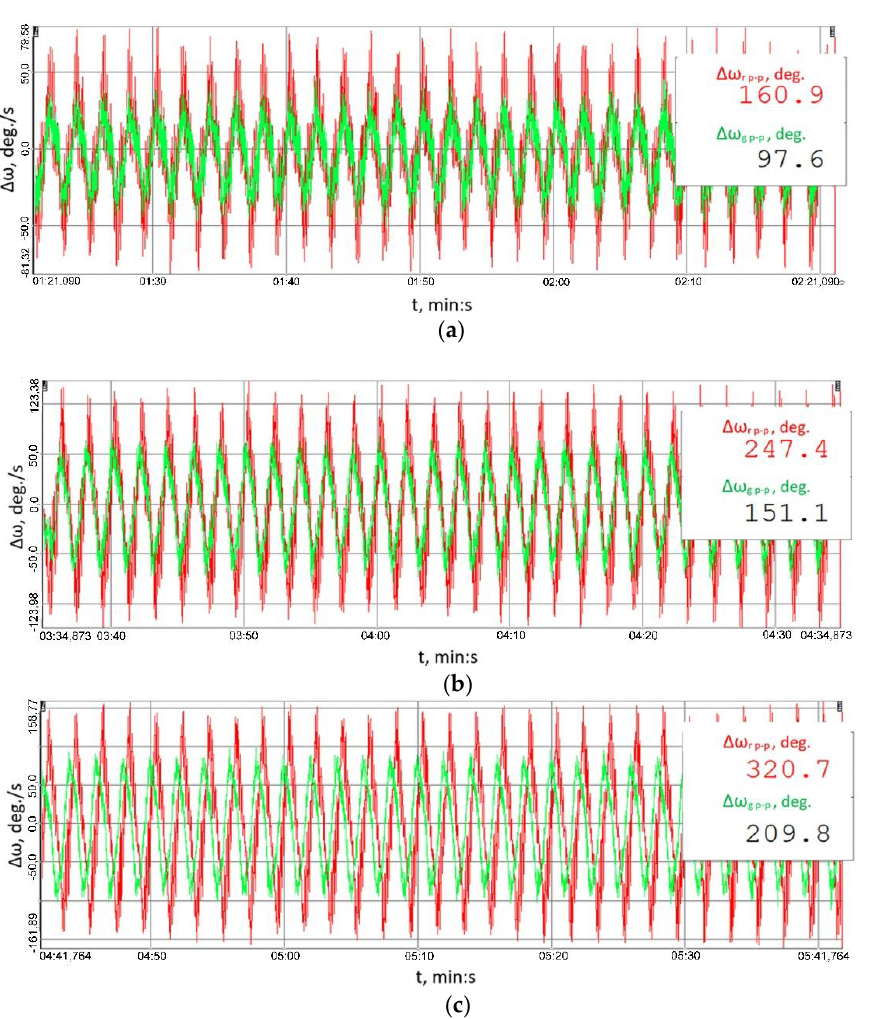
Figure 11. Time histories of instantaneous changes in the velocity of the torsional vibrations of the shaft between the clutch and the multi-stage reduction gear recorded by a contactless method for the following load scenarios: ( a ) 41.8 ± 27.9 Nm, ( b ) 79.2 ± 55 Nm, ( c ) 114.8 ± 75.9 Nm; red colour marks the results obtained for the flexible operation mode of the clutch; green colour corresponds to the locked operation mode.